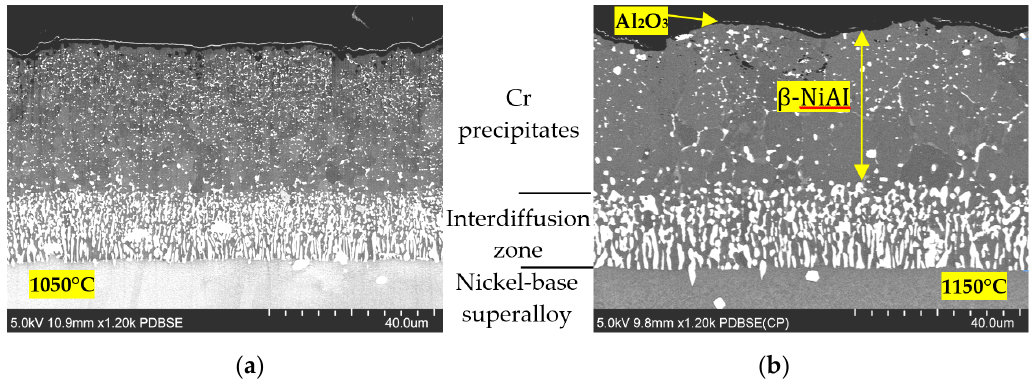
Figure 3. Comparison of the structure of the layers on the superalloy after exposure to temperatures of: ( a ) 1050 ° C; ( b ) 1150 ° C.